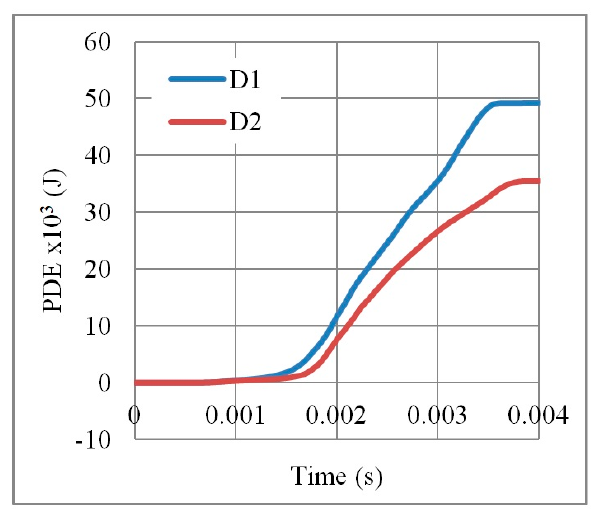
Figure 6. Plastic dissipation energy PDE with respect to time, for an auxetic core loaded in two different directions D1 and D2 ( t = 0.75 mm, L = 5 mm, t/L = 0.15, 𝜃 = 60°, AL2 grade) .